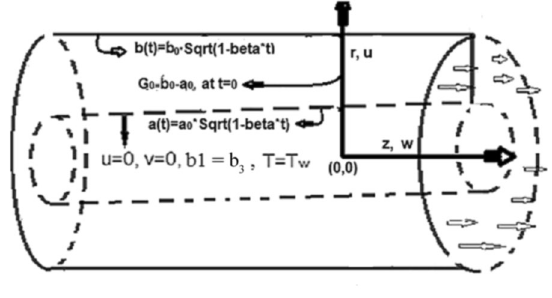
Figure 1. Geometry of the problem with Coordinate